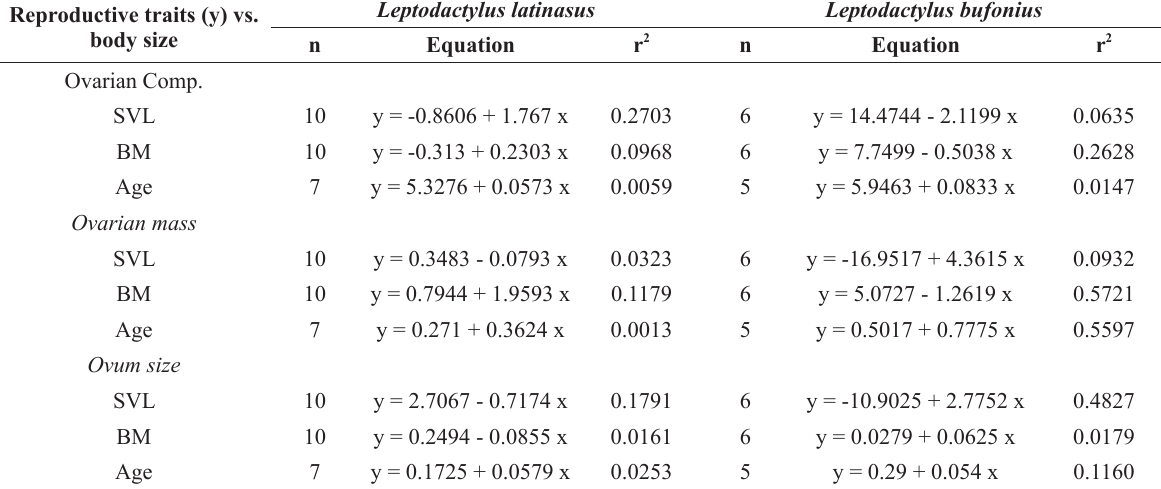
Relationship between reproductive variables (i.e. ovarian complement, ovarian mass, ovum size), body size (snout-vent length, body mass) and age in Leptodactylus latinasus and L. bufonius females. All variables were log-transformed. All relationships were statistically not